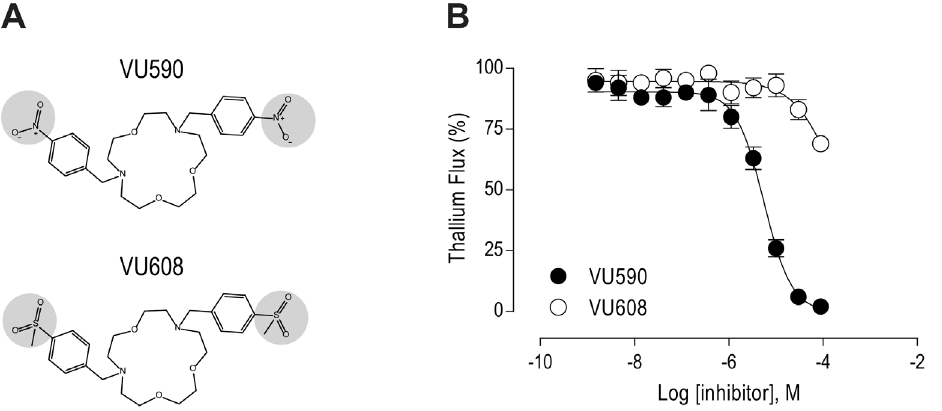
Figure 1. Effects of VU590 and VU608 on Ae Kir1 channels expressed heterologously in TREx-HEK293 cells. (A) Chemical structures of the Ae Kir1 inhibitor VU590 and its ‘inactive’ analog VU608. Gray shading highlights the chemical differences between the molecules. (B) Concentration-response curves of VU590 (filled circles) and VU608 (open circles) derived from Tl + -flux assays. Values are means 6 SEM. n =2 independent experiments, each performed in triplicate. The calculated IC 50 values for VU590 and VU608 are 5.6 m M (95% CI: 4.3–7.2 m M) and . 100 m M, respectively. doi:10.1371/journal.pone.0100700.g001 PLOS ONE |